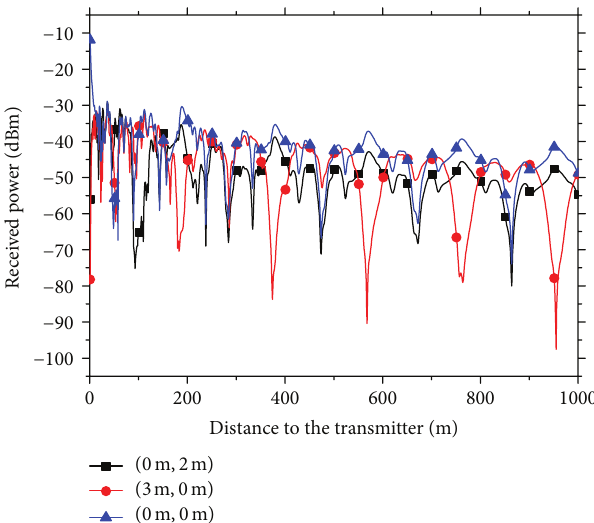
Figure 7: Variations of received powers along the tunnel axis for different antenna locations, in which the azimuth and elevation angles of the antenna beam are 0 ∘ and the antenna beam width is 30 ∘